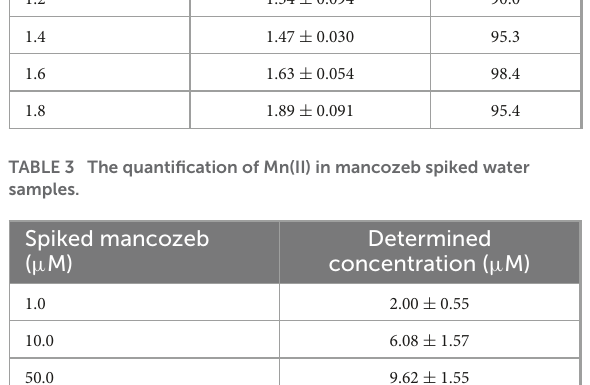
Spiked Mn(II) ( µ M)